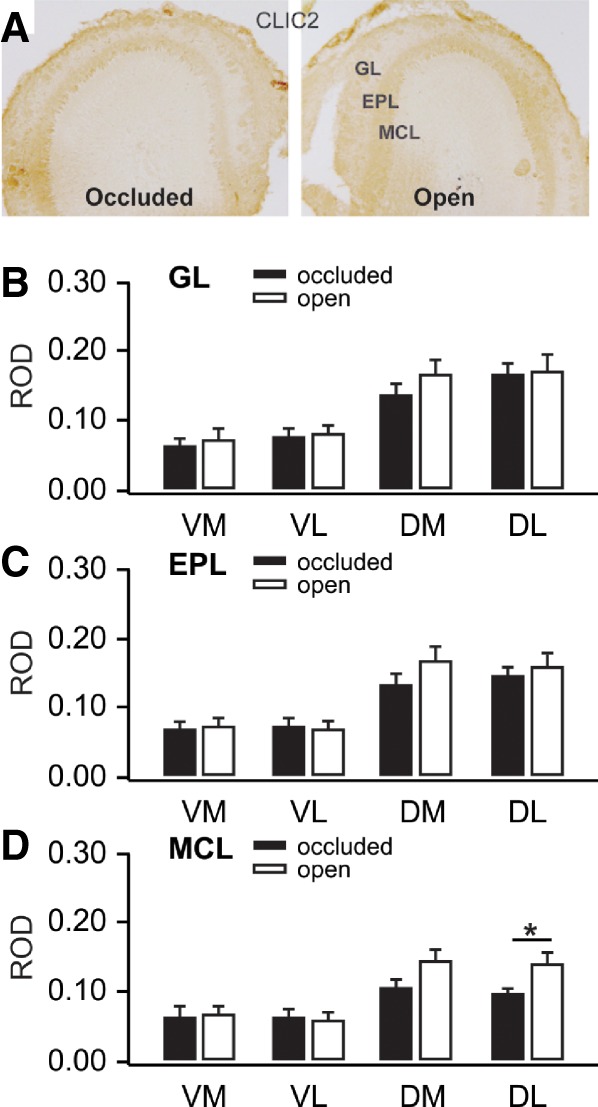
(A) Clic2 immunohistochemical staining in olfactory bulbs ipsilateral to occluded and open nares 50 min following odor + stroking training. (B) Glomerular layer ROD values for olfactory bulb quadrants receiving input from occluded and open nares. (C) External plexiform ROD values for olfactory bulb quadrants receiving input from occluded and open nares. (D) Mitral cell layer ROD values for olfactory bulb quadrants receiving input from occluded and open nares. Error bars represent SEMs. * P < 0.05, see results for exact values.